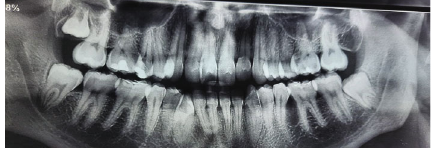
Figure 2: Panoramic radiograph from 2016 demonstrating a well- de fi ned unilocular radiolucent lesion in the left mandible.